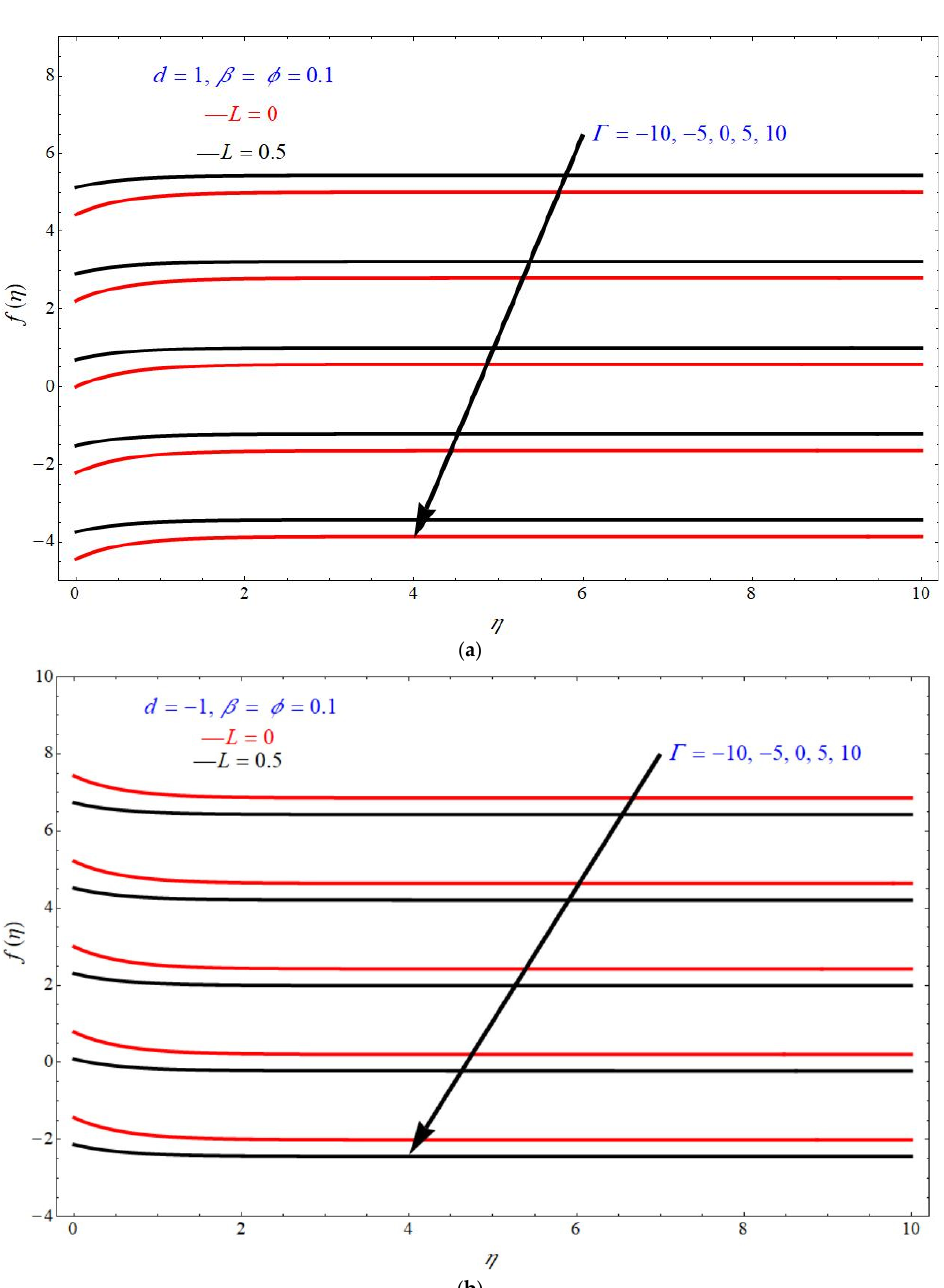
Figure 2. Effect of f ( η ) on η for various choices of Γ ( a ) stretching and ( b ) shrinking cases.